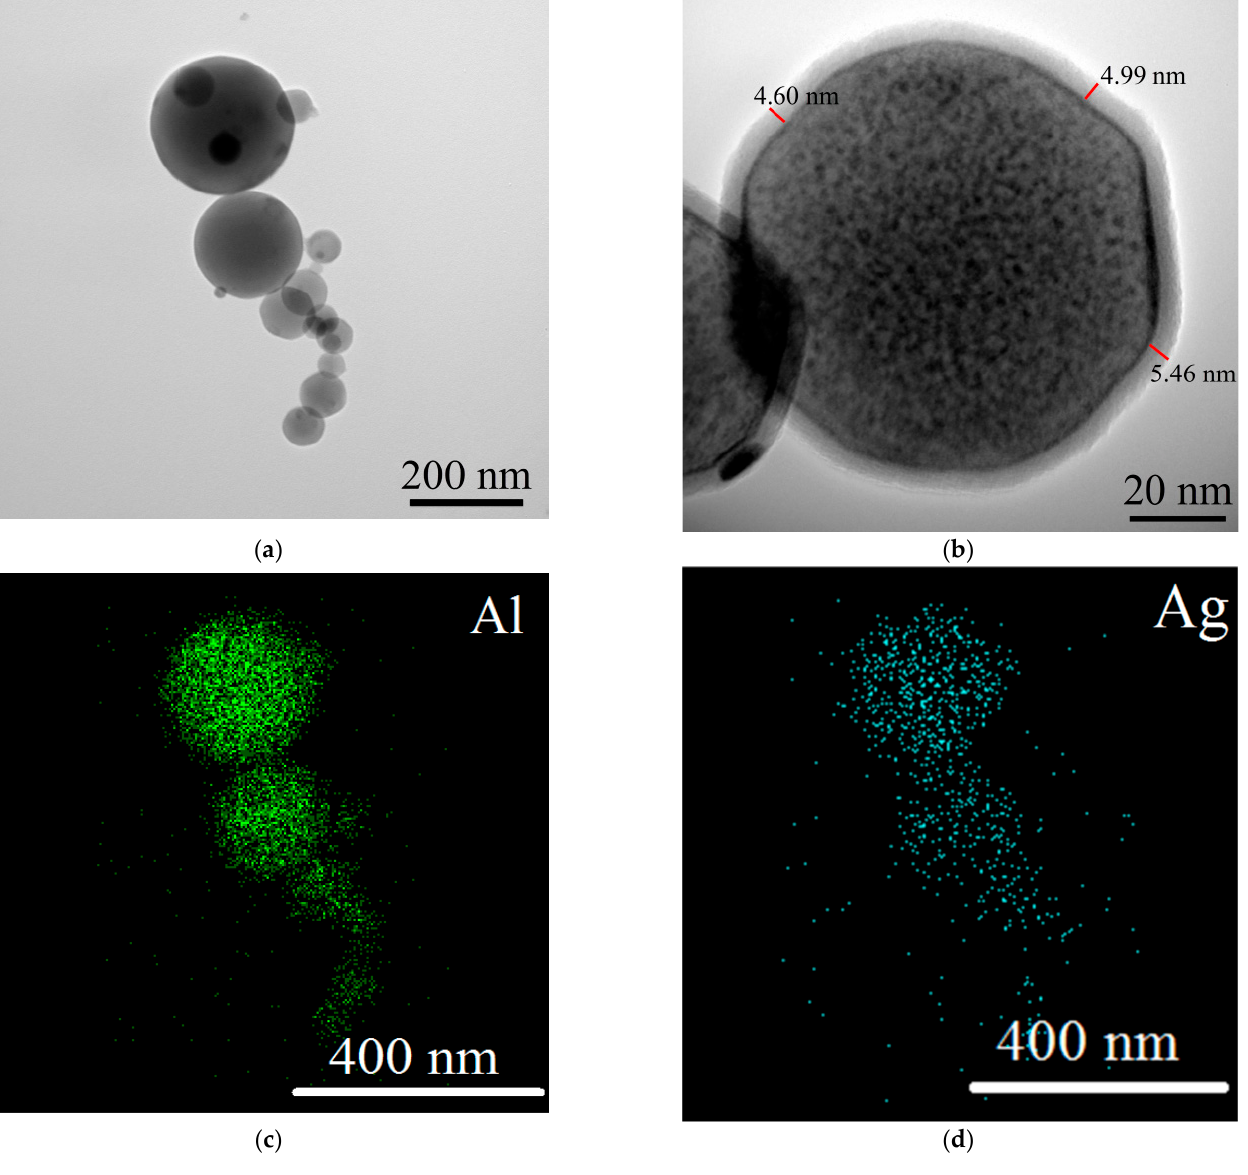
Figure 1. TEM images ( a , b ) and TEM-EDS mapping ( c , d ) of Al/Ag nanoparticles.